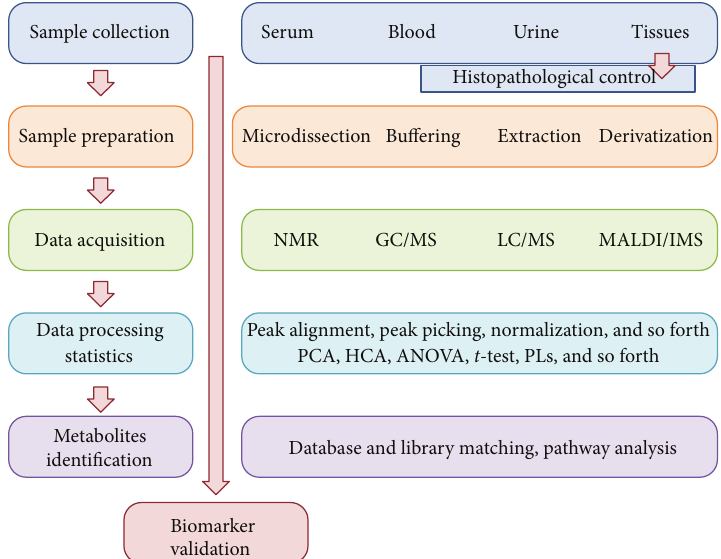
Figure 2: The general workflow of metabolomics analysis in cancer